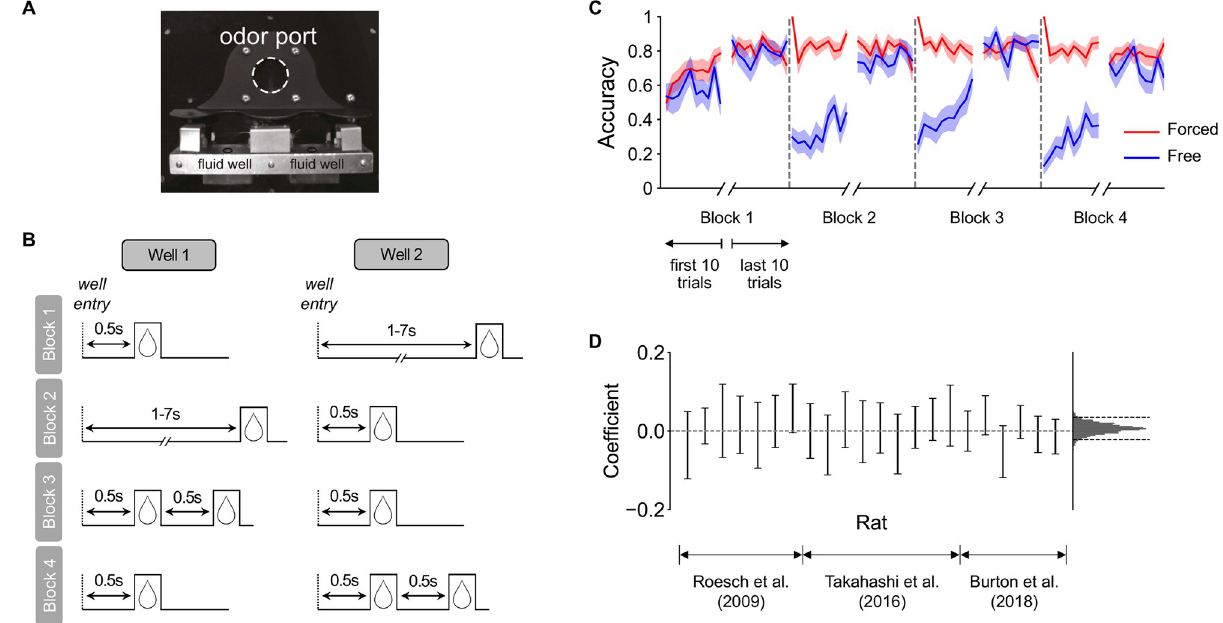
Fig 1. The odor-guided choice task and animals’ behavior. (A) The experiment apparatus included an odor port and two fluid wells where rewards were delivered. To start each trial, the animal first poked into the odor port; after 0.5 seconds, one of three odors was delivered, signaling the current trial type. One odor signaled a left forced-choice trial, another a right forced-choice trial, and a third indicated free choice between left and right wells. After odor offset, the animal could make a choice by entering either the left or right fluid wells. Reward was delivered if they made the correct choice on a forced-choice trial and as long as they successfully made one of the choices on a free-choice trial. (B) Block sequence in an example session. Sessions always started with two “delay blocks” (blocks 1 and 2), followed by two “magnitude blocks” (blocks 3 and 4). In block 1, the “short” reward (delivered 0.5s after well entry) was available in one well and the “long” reward (delivered 1–7s after well entry) in the other; the reward contingency switched between the wells on block 2. In block 3, “long” reward then changed to “big” reward (two sucrose drops delivered 0.5s after well entry), while “short” reward stayed the same but is now referred to as “small” reward (one sucrose drop) in comparison to the alternative; these reward contingencies were switched again on block 4. The well that was initiated with the better (short) reward option was randomized across sessions. (C) Learning curves for forced-choice (red) and free-choice (blue) trials. The curves are aligned to block-switch points (gray dashed lines), with the first and last 10 trials of each block shown. Accuracy is evaluated as the percentage of trials the animal chose the better option for that trial type (forced-choice trials: the rewarded well; free-choice trials: the well with reward at shorter delay or larger amount). Shaded areas represent 1 s.e.m across animals ( N = 22). (D) Coefficients of a hierarchical logistic regression predicting the accuracy of the first free-choice trial after a previous incorrect free-choice as a function of the number of intervening correct forced-choice trials. Left (error bars): coefficients for individual animals, ordered by dataset, with error bars representing 95% highest posterior density interval (HDI). Right (histogram): the posterior distribution of the group mean, with dashed lines representing 95% HDI. At both individual and group levels, 95% HDI of the coefficients overlapped with zero, suggesting that there was minimal generalization of learning from correct forced-choice trials to subsequent free-choice